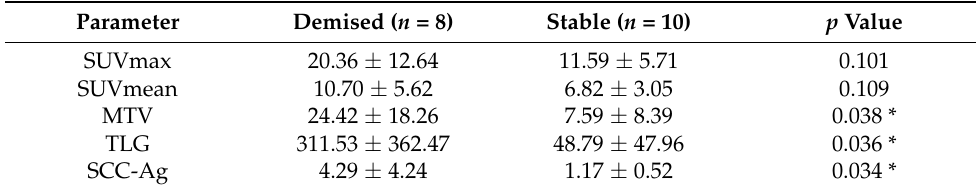
Table 4. Comparison of the tumor metabolic parameters of demised versus stable patients by independent t -test.